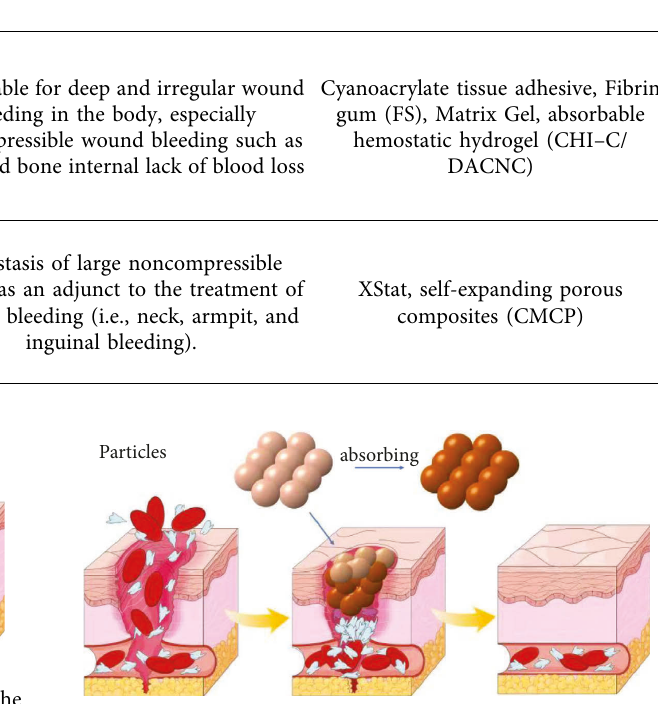
Figure 2: The small particle structure of hemostatic powder ab- sorbs the water in the blood, effectively concentrates the blood, and closely fits with the damaged tissue under the action of external forces, while with the help of some positively charged components such as chitosan, electrostatic effect occurs with negatively charged red blood cells, prompting the local formation of blood clots to accelerate